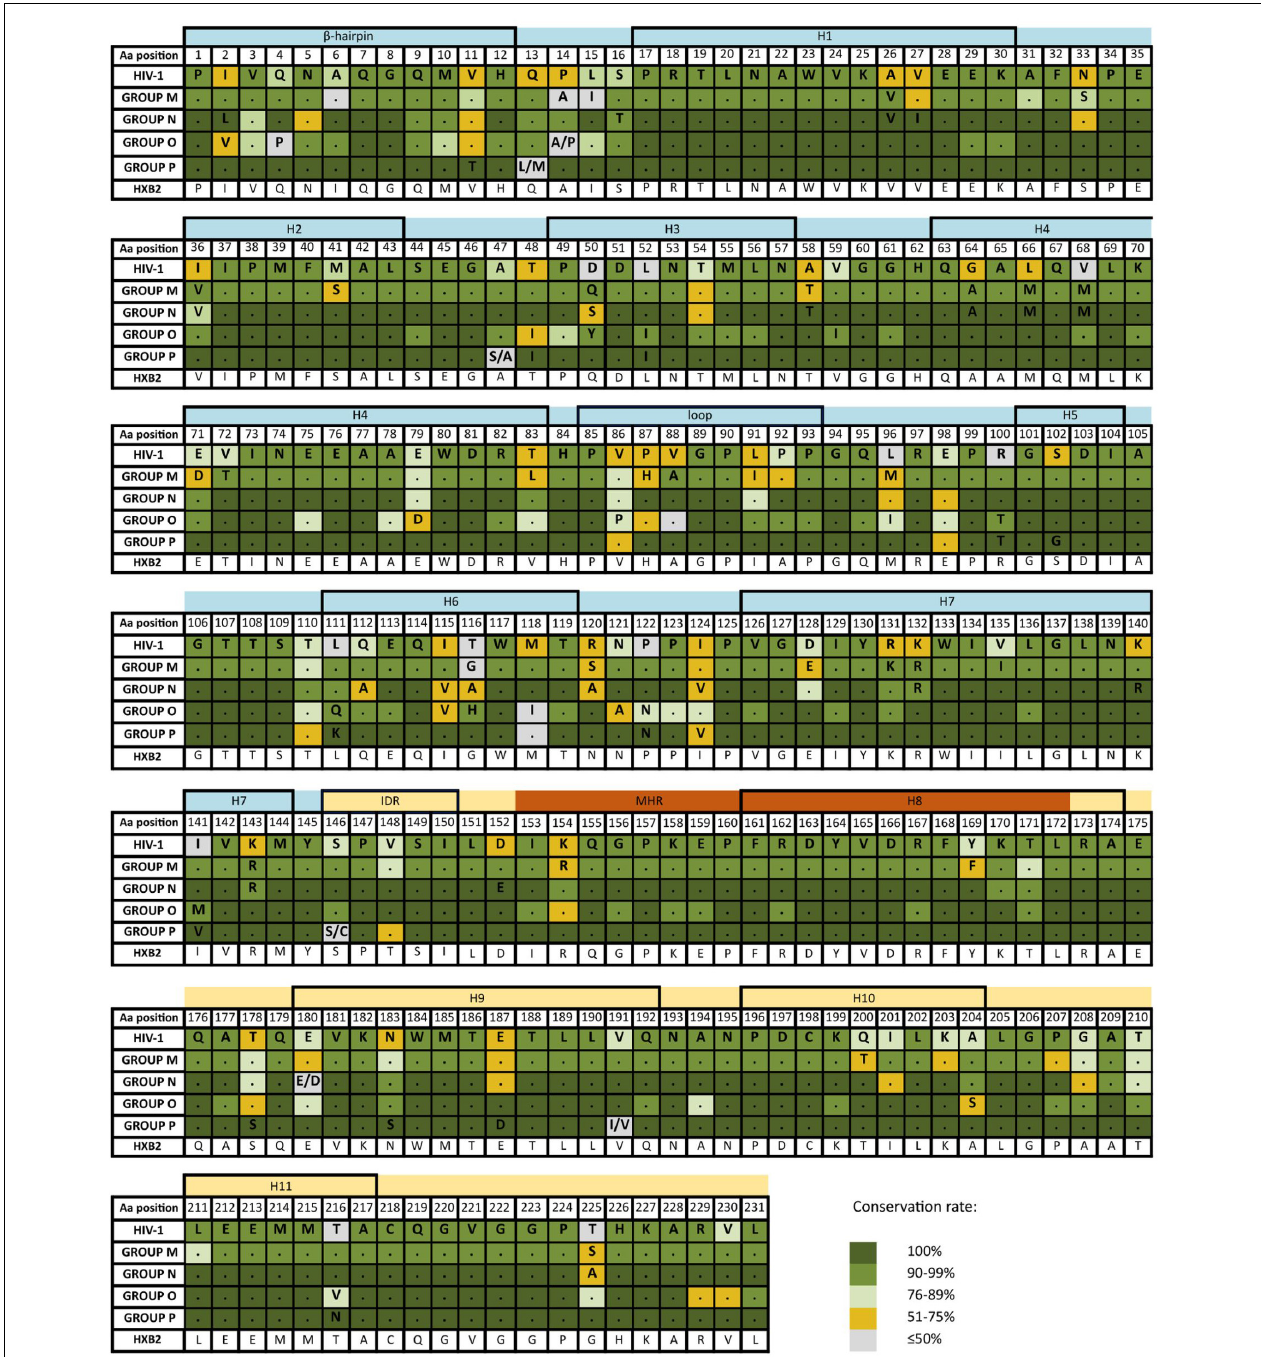
FIGURE 1 | Amino acid conservation percentage along p24 secondary structure in HIV-1 and each HIV-1 group. Aa, amino acid. The aa for each position in groups M, N, O, and P are in reference to HIV-1 consensus. Dots represent the same aa as HIV-1 consensus for that position. The HXB2 reference sequence is described for further guidance below the groups. Colors represent the conservation percentage. P24 domains and secondary structure regions: H, helix; IDR, interdomain linker region; MHR, major homology region; in light blue, N-terminal domain; in light yellow, C-terminal domain; in dark orange, MHR. Aa code: A, alanine; C, cysteine; D, aspartic acid; E, glutamic acid; F, phenylalanine; G, glycine; H, histidine; I, isoleucine; K, lysine; L, leucine; M, methionine; N, asparagine; P, proline; Q, glutamine; R, arginine; S, serine; T, threonine; V, valine; W, tryptophan; Y, tyrosine. Residues P1 and H12 in the β -hairpin and R18 and D51 in the α -helixes 1 (H1) and 3 (H3) are involved in the hexameric pore